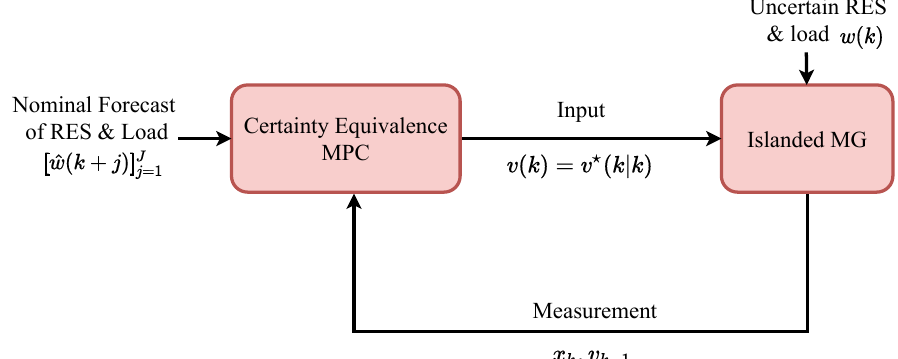
Figure 1. Certainty equivalence MPC scheme for operation of islanded MG at time instant k and ∀ j = 0, . . . , J −